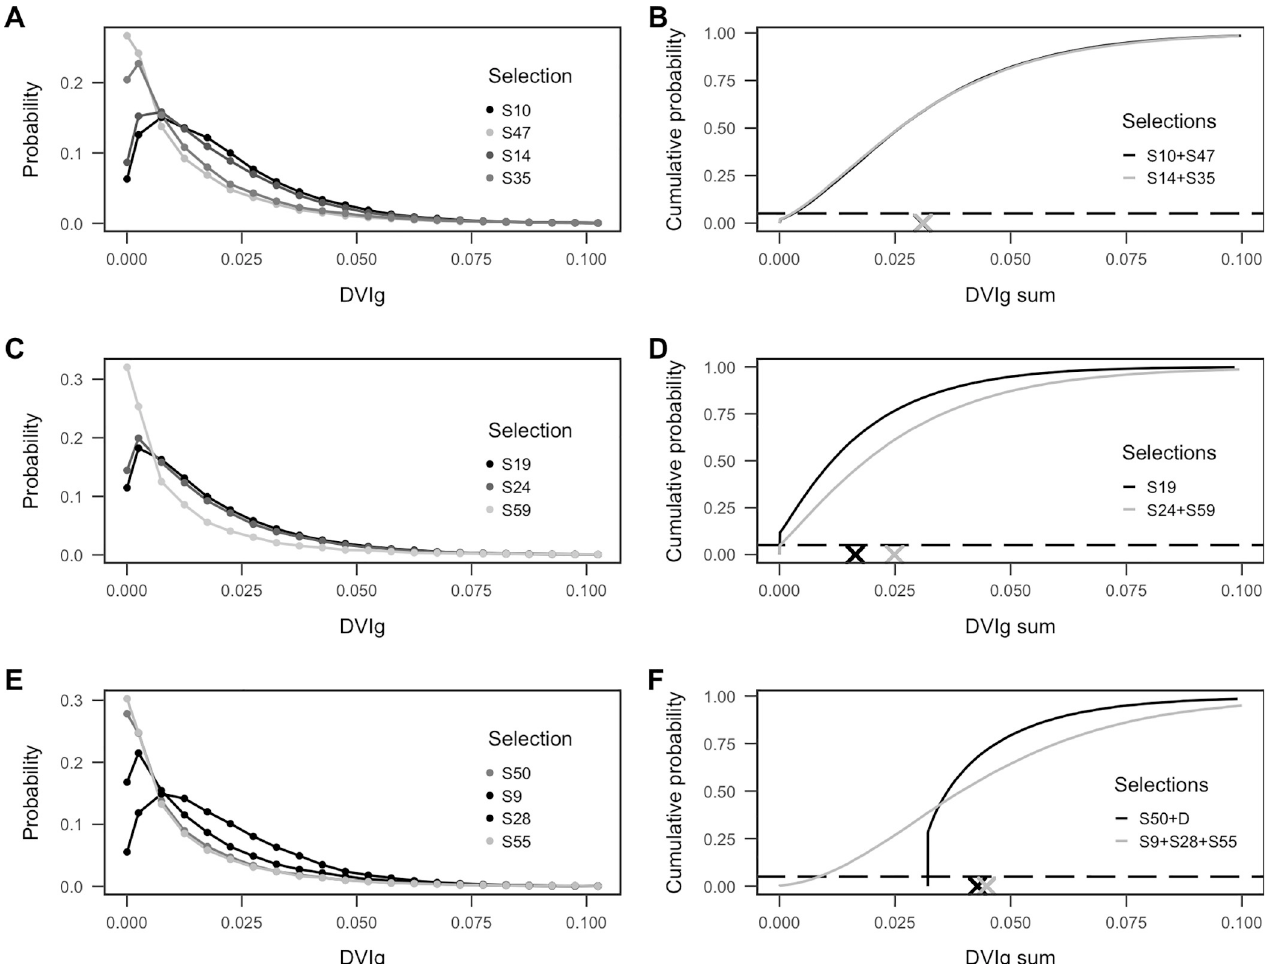
Fig 5. Comparison of selection distributions for AFL trades using DVIg. Probability distributions describing uncertainty in DVIg for individual selections predicted by the best-fit model (left column) and the predicted cumulative distribution of the summed DVIg when traded (right column). The probability distributions show the probability DVIg = 0 (leftmost probability) and the remaining probabilities depict the likelihood of DVIg values lying within bins of width 0.005. Dashed horizontal lines indicates the 5 th percentile. Crosses indicate the expected summed DVIg (i.e. mean) of the trade. A club is deemed to have benefitted if its cumulative curve is always to the right of its trading partner’s. (A-B) Adelaide and Geelong trade in 2014 [Adelaide: S10 + S47, Geelong: S14 + S35]. (C-D) Hawthorn and St. Kilda trade in 2013 [Hawthorn: S19, St. Kilda: S24 + S59]. (E-F) Geelong and Adelaide Dangerfield trade in 2015 [Geelong: D + S50, Adelaide: S9 + S28 +